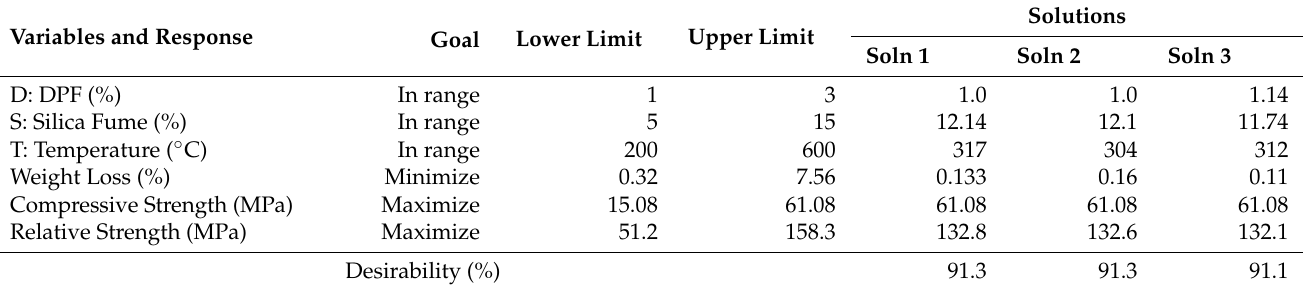
Table 9. Multi-objective optimization